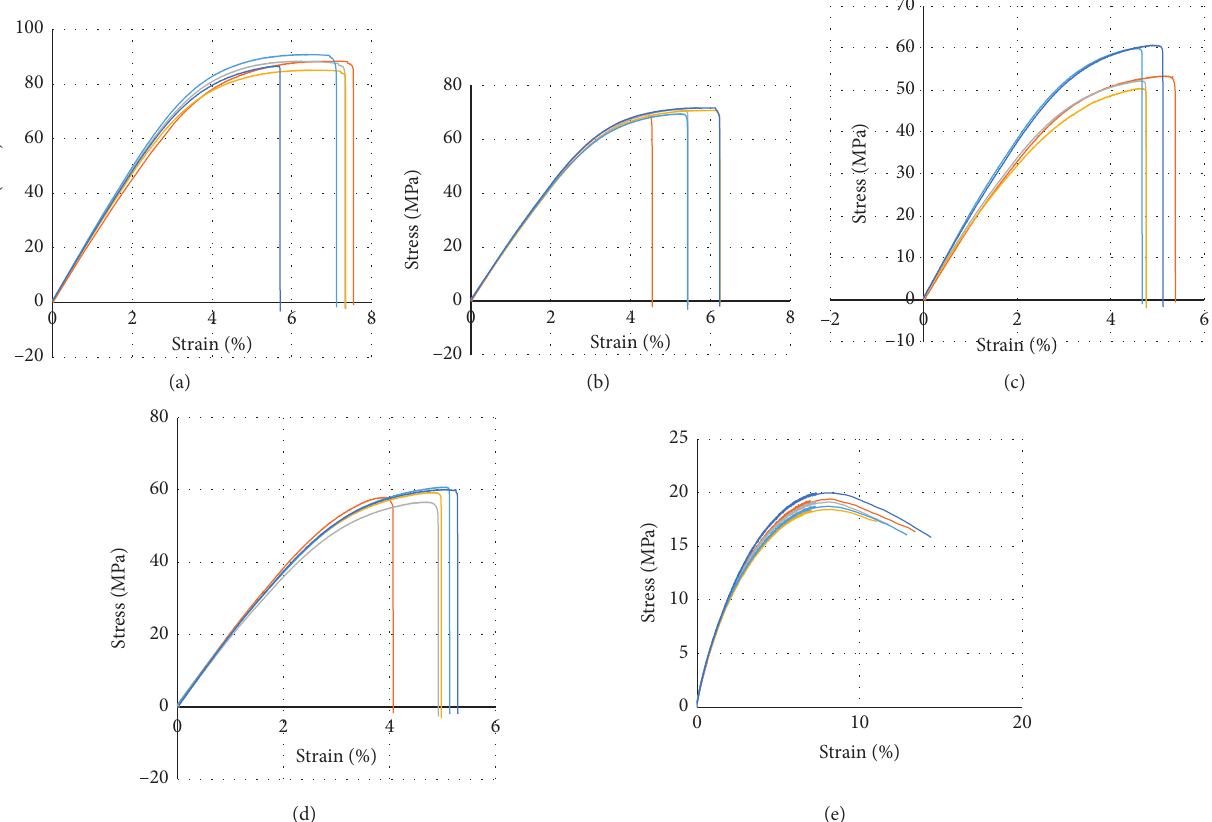
Figure 11: The stress-strain curves of the flexural test of the PBT/HDPE blends: (a) 0% HDPE, (b) 5% HDPE, (c) 10% HDPE, (d) 15% HDPE, and (e) 100% HDPE.